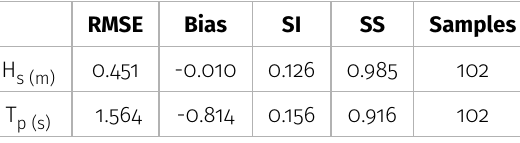
Table III. Statistical parameters for extreme event analysis: Model x